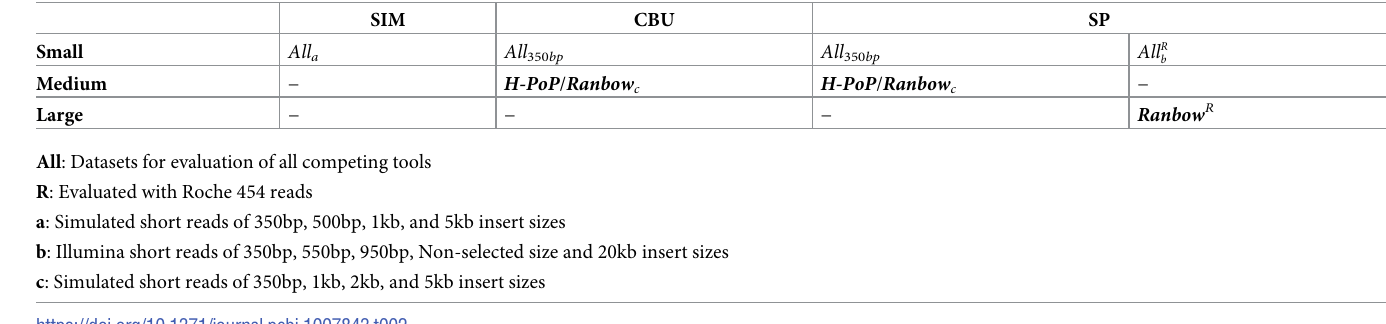
Table 2. Simulated and real datasets for